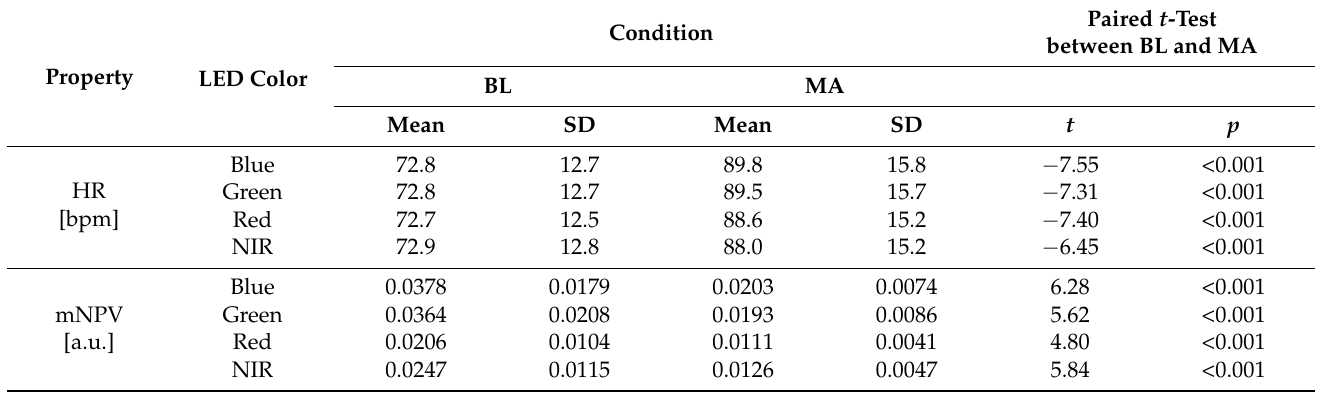
Table 2. Statistical results for HR and mNPV at 4 wavelengths in each